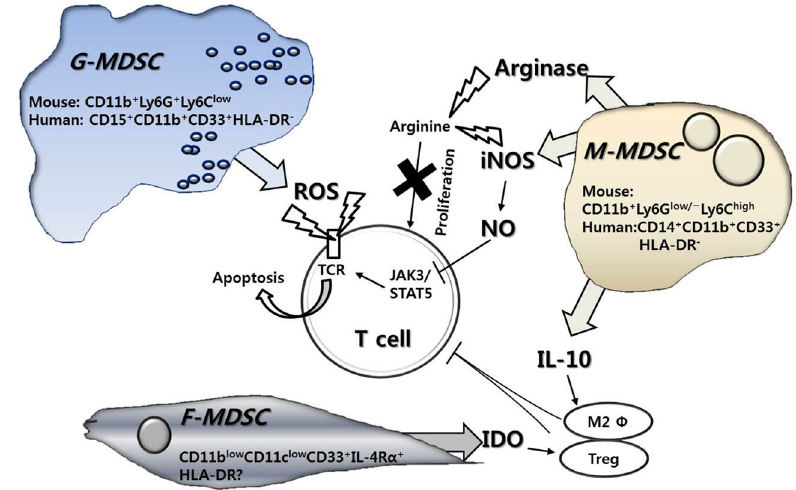
Fig. 1 Strategies of G-, M-, and F-MDSCs for T cell suppression. MDSC myeloid- derived suppressor cell, G- MDSC granulocytic MDSC, M- MDSC monocytic MDSC, F- MDSC fibrocytic MDSC, ROS reactive oxygen species, iNOS inducivle nitric oxide synthase, NO nitric oxide, IL-10 interleukin 10, IDO indoleamine oxidase, TCR T cell receptor, Treg regulatory T cell, M2 u M2